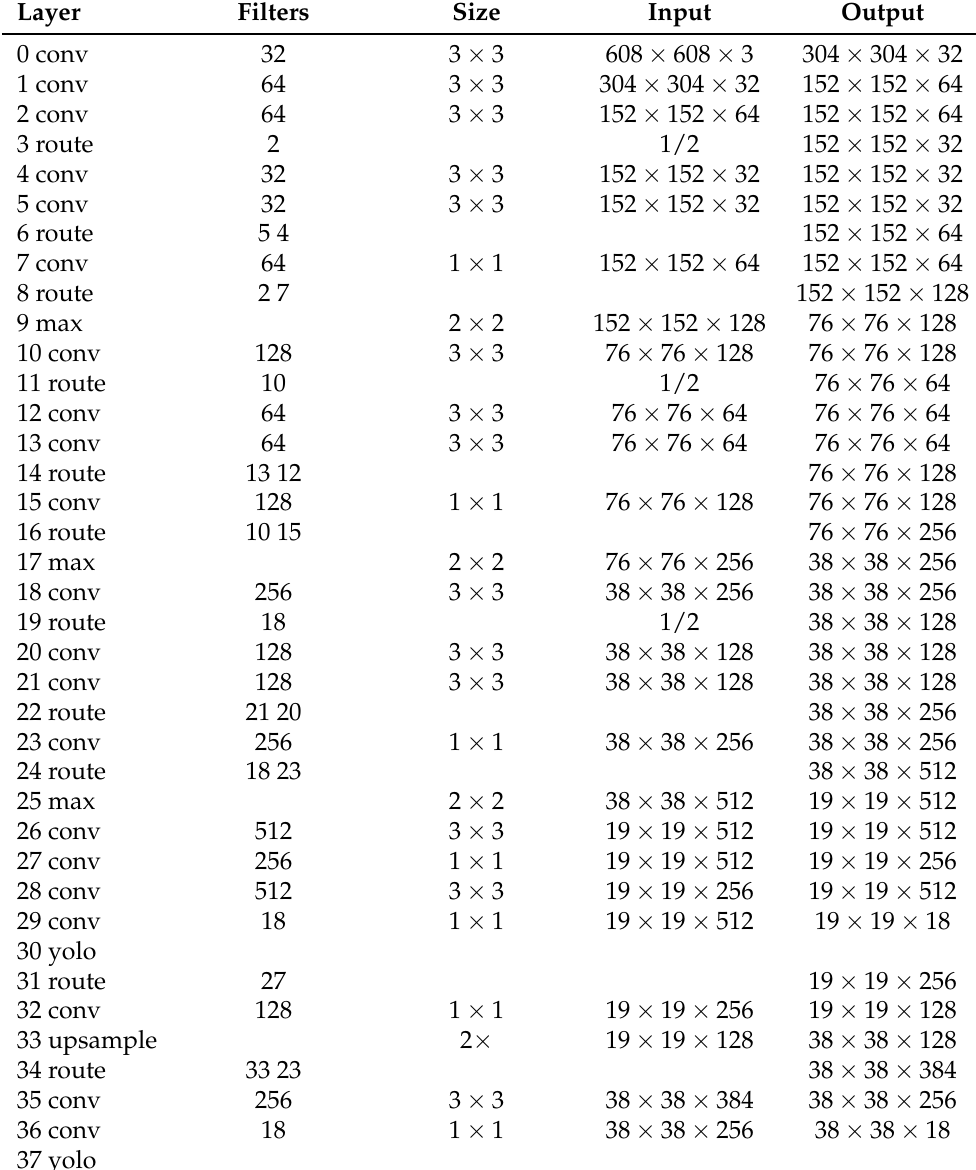
Table A5. Tiny YOLOv4 Architecture. Layer 30: [yolo] params: iou loss: ciou, iou norm : 0.07, obj norm : 1.00, cls norm : 1.00, delta norm : 1.00, scale xy : 1.05 nms kind : greedynms, beta = 0.600000. Layer 37: [yolo] params: iou loss: ciou, iou norm : 0.07, obj norm : 1.00, cls norm : 1.00, delta norm : 1.00, scale xy : 1.05 nms kind : greedynms, beta =